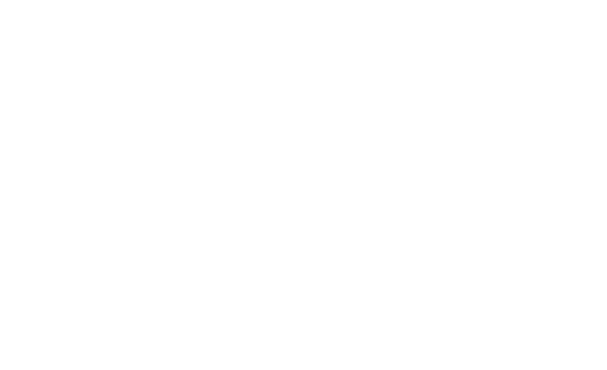
Table 8. Information on HOC job with